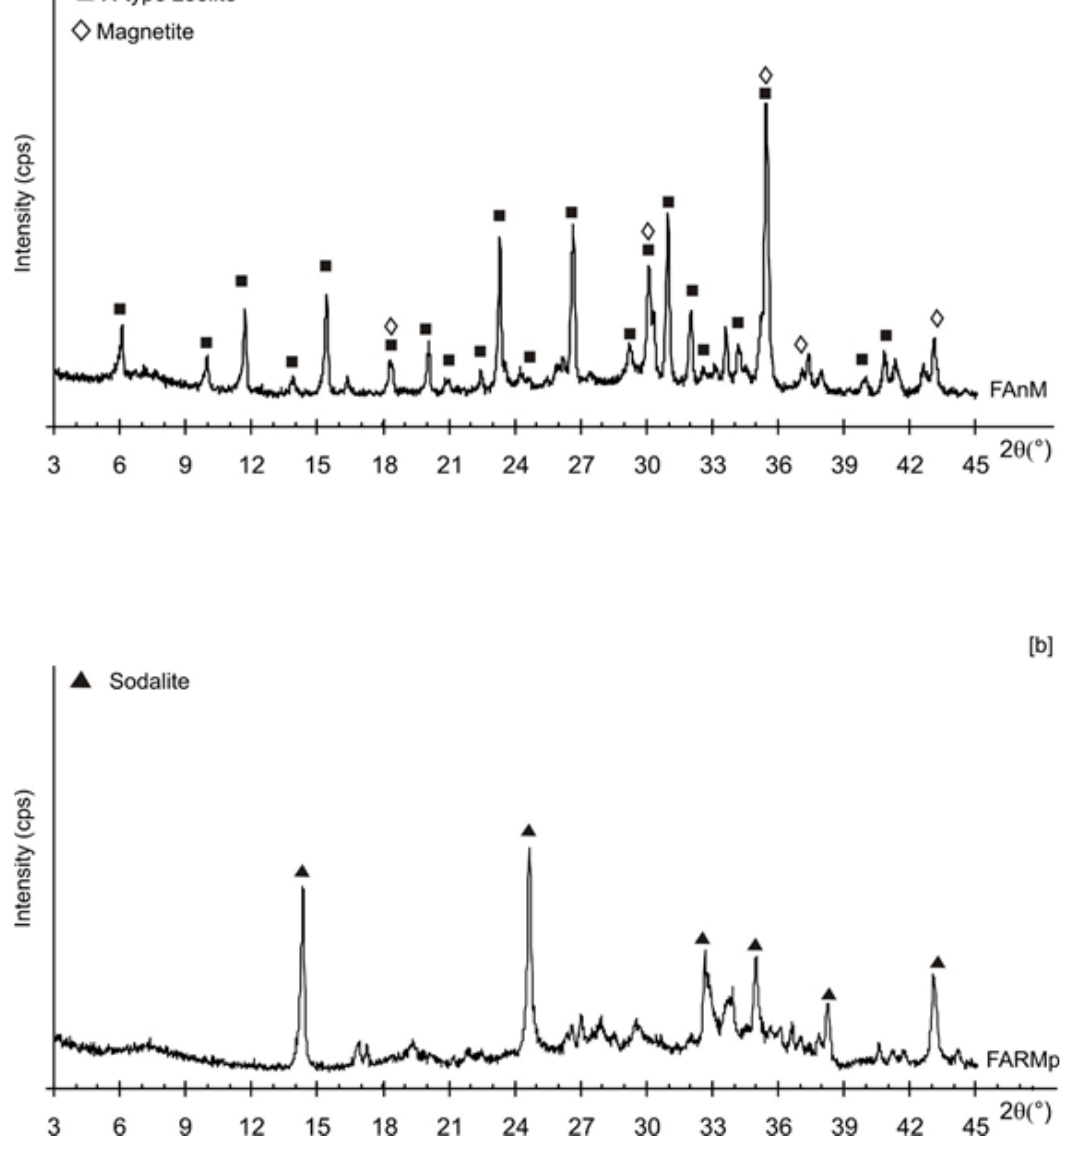
Figure 5. XRD patterns of: ( a ) FAnM and ( b ) FARMp samples.